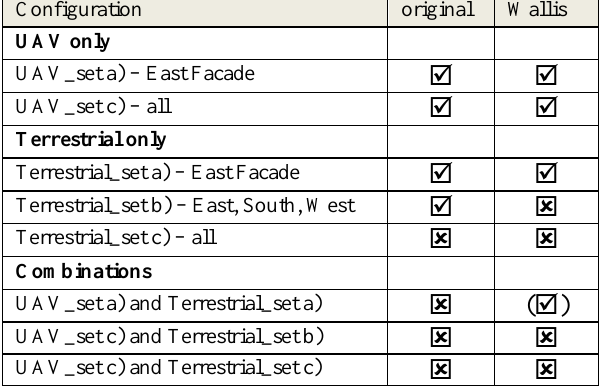
Table 1: Experimental results with pix4dmapper on several image block subsets.